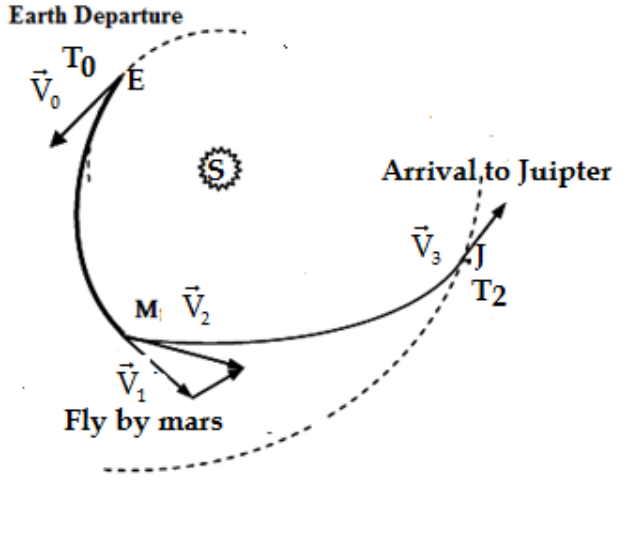
Fig. 1 Description of the mission from Earth to fly by with